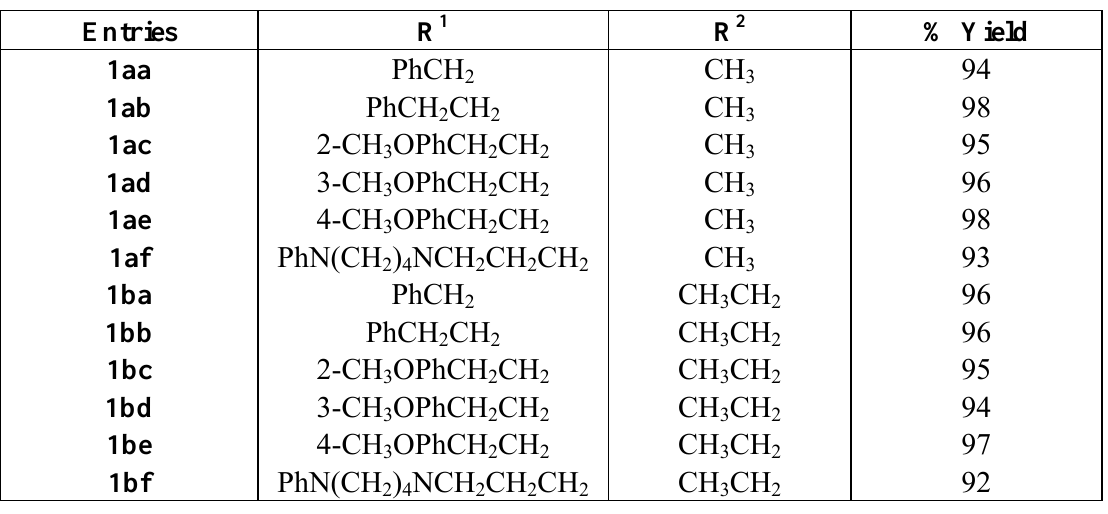
Table 1. Alkylated